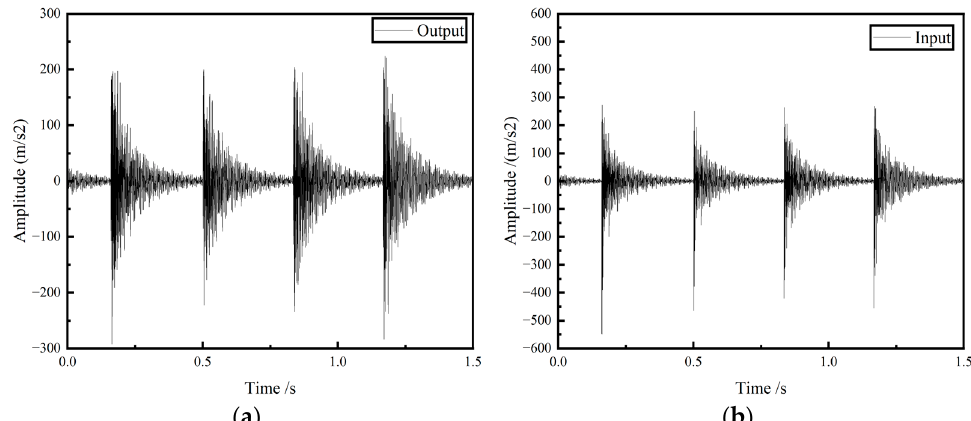
Figure 12. The response curves of GFRP wave springs, ( a ) time domain input signal, ( b ) time domain output signal.